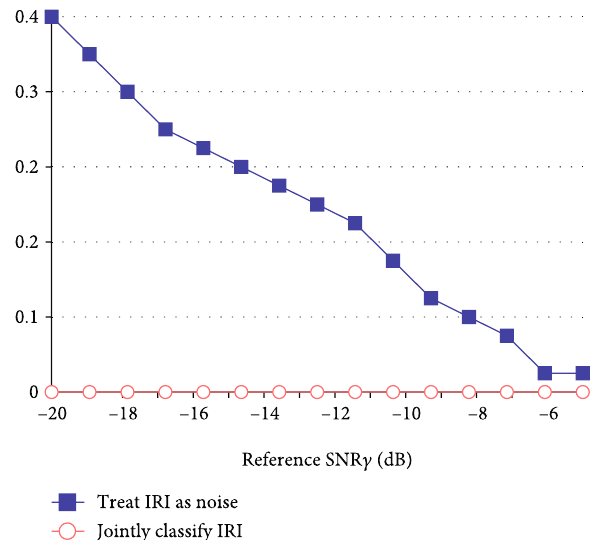
Figure 1: Theoretical performance curve of the algorithm based on the likelihood function.